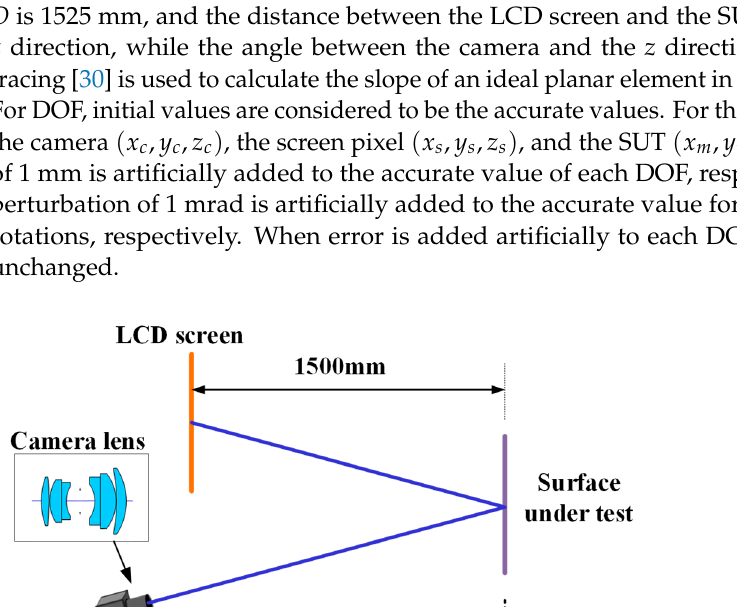
Table 1. The difference in Zernike coefficient caused by the disturbance of each degree of freedom. Unit: nm. Zernike Terms/Degree of Free- dom